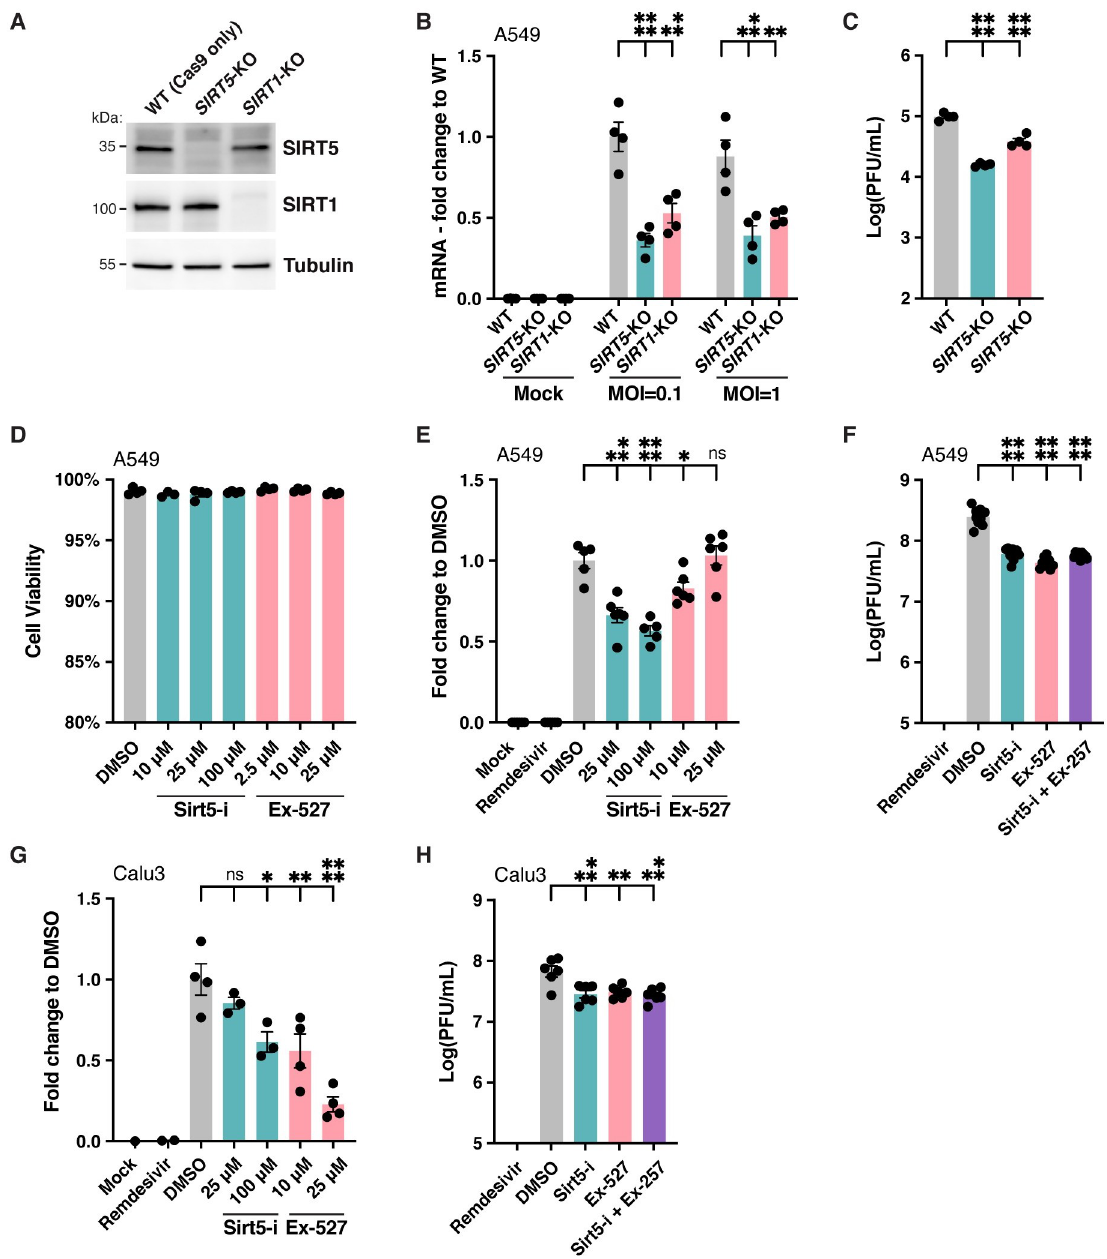
Fig 4. SIRT5 is a proviral factor. A . Western blot showing the absence of SIRT5 and SIRT1 in SIRT5- and SIRT1- KO A549-ACE2 cells, after CRISPR knockout. B . Decrease in cell-associated viral mRNA levels in SIRT5- and SIRT1- KO cells infected with SARS-Cov-2 for 3 days at MOI = 0.1 or MOI = 1, as shown by RT-qPCR. Data show fold-changes compared to WT levels at MOI = 0.1. n = 4. C . Decrease in viral titers in SIRT5- and SIRT1- KO cells infected with SARS-Cov-2 for 3 days at MOI = 1, as shown by plaque assay. n = 4. D . Absence of cytotoxicity in A549-ACE2 cells treated with Sirt5-i and Ex-527 inhibitor, as measured by flow cytometry. n = 4. E . Decrease in cell- associated viral mRNA levels in A549-ACE2 cells infected with SARS-Cov-2 for 3 days at MOI = 0.1, and treated with SIRT5 and SIRT1 inhibitors Sirt5-i and Ex-527, as shown by RT-qPCR. Data show fold-change compared to DMSO-treated levels. n = 6. F . Decrease in viral titers in A549-ACE2 cells infected with SARS-Cov-2 for 3 days at MOI = 0.1, and treated with SIRT5 and SIRT1 inhibitors Sirt5-i and Ex- 527, as shown by plaque assay. n = 9. G/H. Same as E. (with n = 4), and F. (n = 6), using Calu3 cells. B-H . Data show mean and standard error of the mean (SEM) between biological replicates. RT-qPCR results were internally normalized with GAPDH and ACTIN reference genes. Viral titers after plaque assay are expressed in log-transformed PFU (plaque-forming unit) per mL of supernatant. Asterisks summarize the results of one-way ANOVAs followed by Holm–Sˇida´k multiple comparisons test (on log-transformed data for plaque assays) � : p < 0.05, �� : p < 0.01, ��� : p < 0.001, ���� : p < 0.0001.